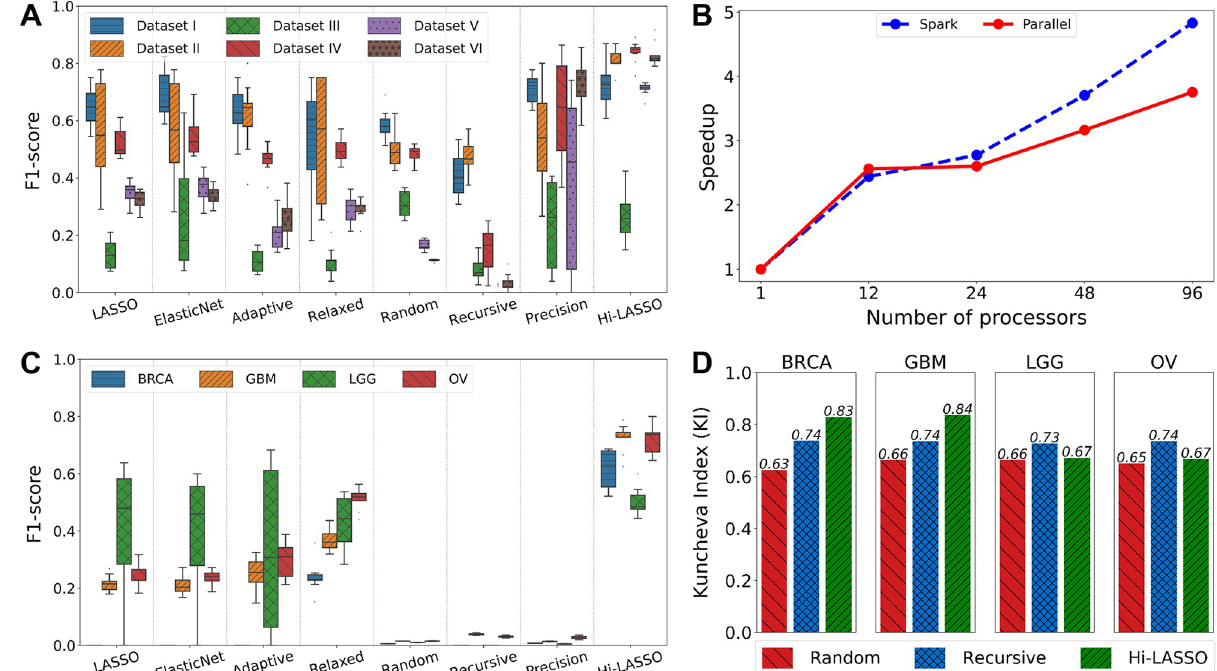
Fig 1. Experimental results. (A) Comparison of F1-scores with the simulation data, (B) improvement of efficiency on the Hi-LASSO Python package and the Spark version, (C) comparison of F1-scores with the semi-real simulation data, and (D) robustness of feature